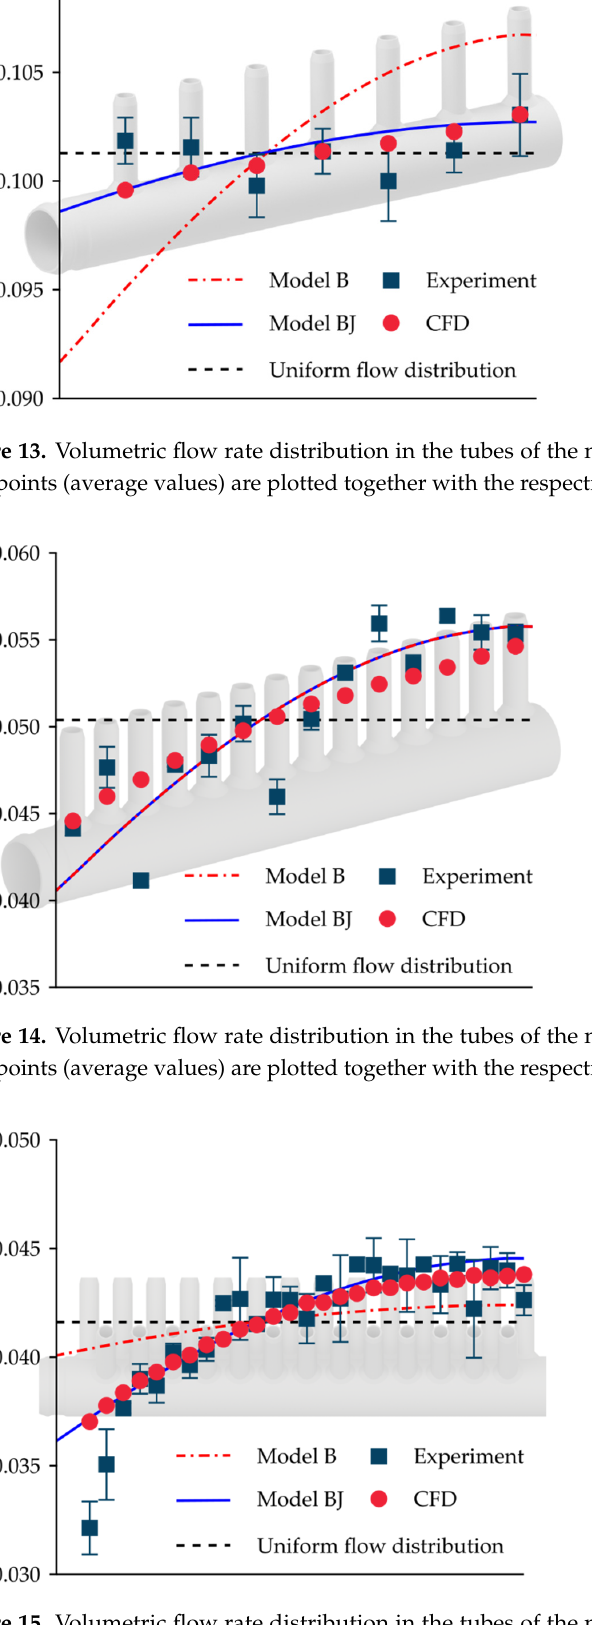
Figure 15. Volumetric flow rate distribution in the tubes of the n27 distributor. The experimental data points (average values) are plotted together with the respective observed value intervals.